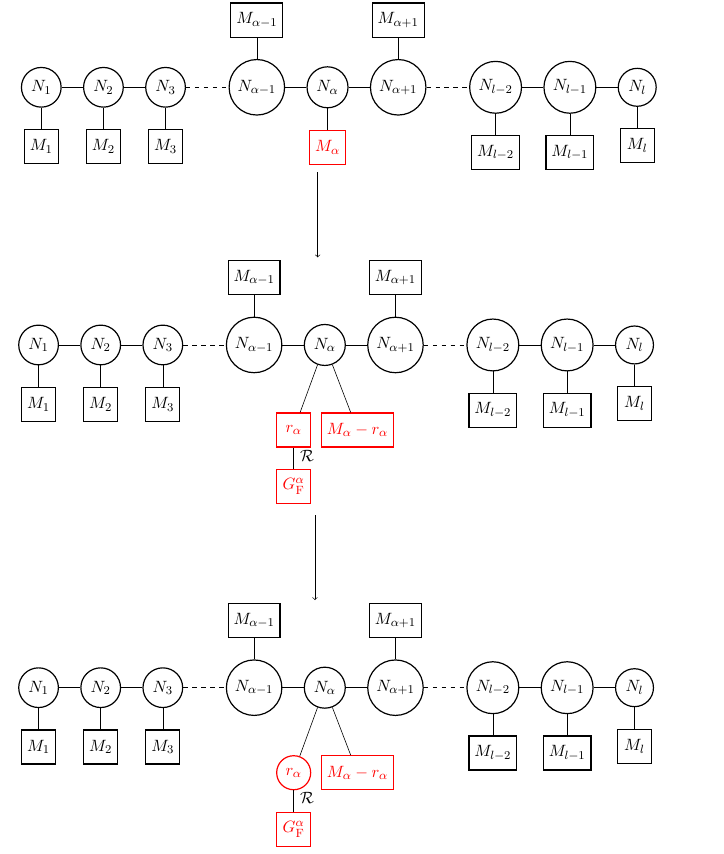
on a generic linear ◦ F α P P